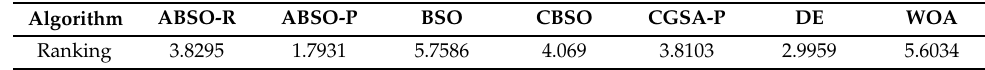
Table 2. Results of the Friedman nonparametric statistical test.